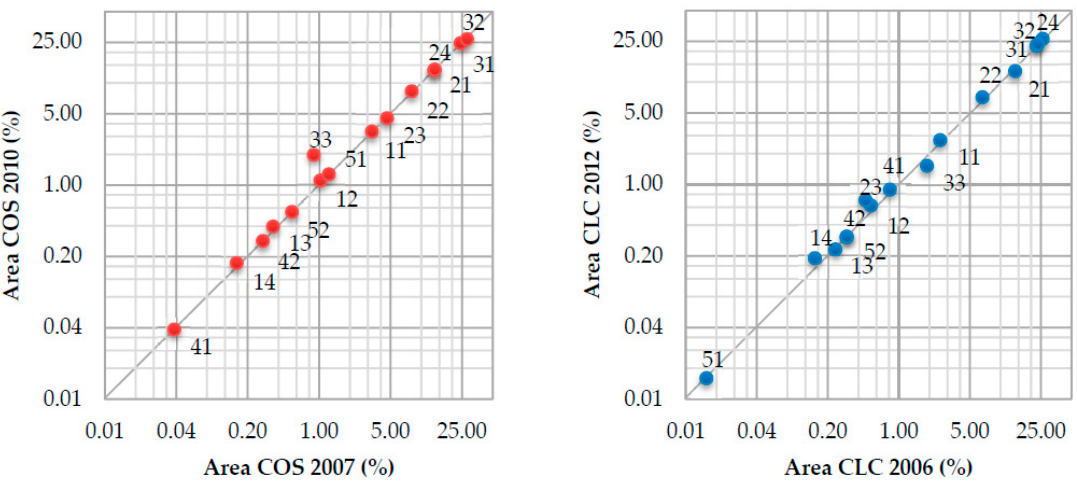
Table 1. Characteristics and properties of LUC